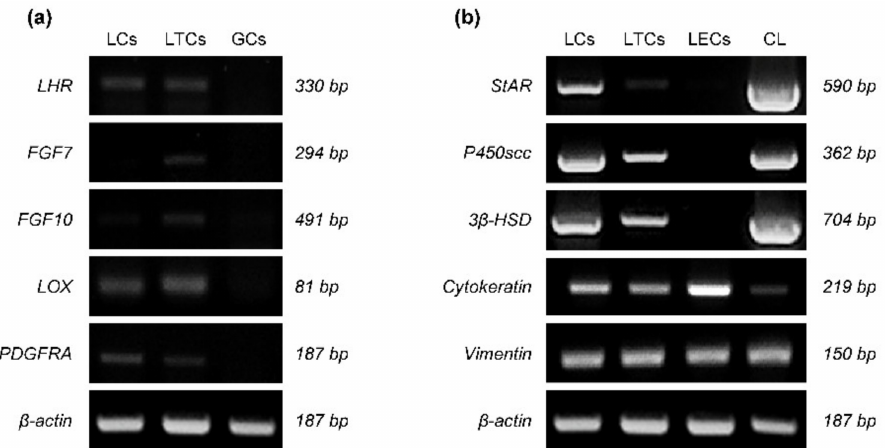
Figure 3. Expression of mRNA related with theca cells lineage markers ( a ), steroidogenic function and intermediate filament ( b ) in bovine luteal theca cells (LTCs). LCa: uteal cells, GCs: granulosa cells, LECs: luteal endothelial cells, CL: secretion-phase corpus luteum (CL), LHR: luteinizing hormone receptor, FGF7: fibroblast growth factor 7, LOX: lysyl oxidase, PDGFRA: platelet derived growth factor receptor alpha, StAR: steroidogenic acute regulatory protein, P450scc: cholesterol side-chain cleavage enzyme, and 3 β -HSD: 3 β -hydroxysteroid